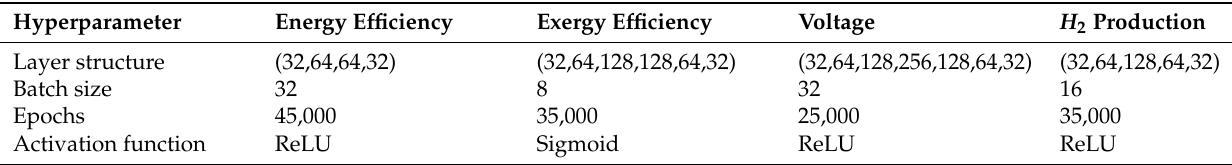
Table 8. The ANN settings for the final model.